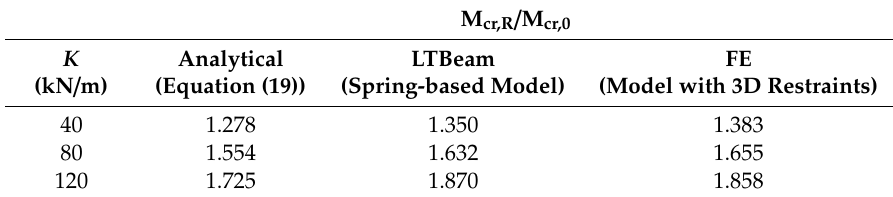
Table 3. Comparison of critical buckling moment variations for the selected beam geometry from Figure 11 ( n b = 1 and n d = 2), as a function of K (3D = three-dimensional).